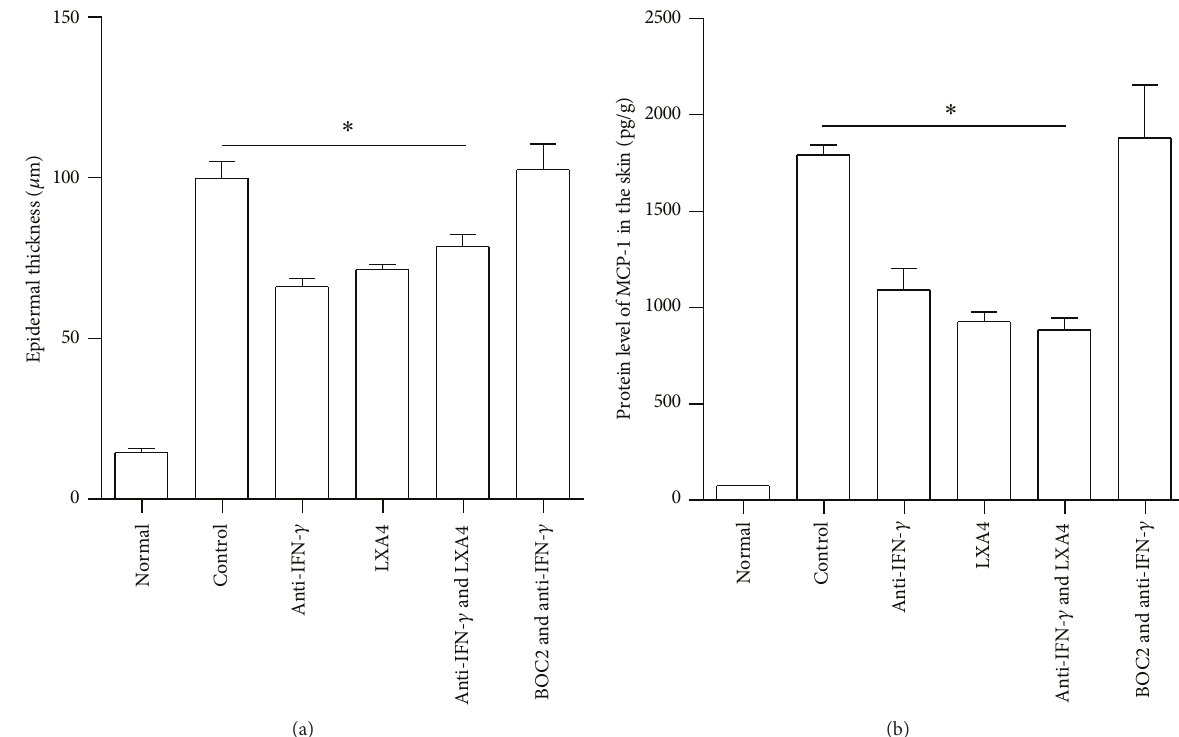
Figure 5: Application of LXA4 obtained a pro-resolution effect, while blocking LXA4 reverted the effect of IFN- 𝛾 neutralization. Three hours after the third PMA painting, mice were divided into 5 groups: control, anti-IFN- 𝛾 , LXA4, anti-IFN- 𝛾 and LXA4, and BOC2 and anti-IFN- 𝛾 . The skin tissues were removed 4 days after the third PMA treatment. Epidermal thickness (a) was analyzed by HE staining as described in Methods. The MCP-1 expression level (b) in the skin was detected by CBA. ∗ 𝑃 < 0.05 , compared to control